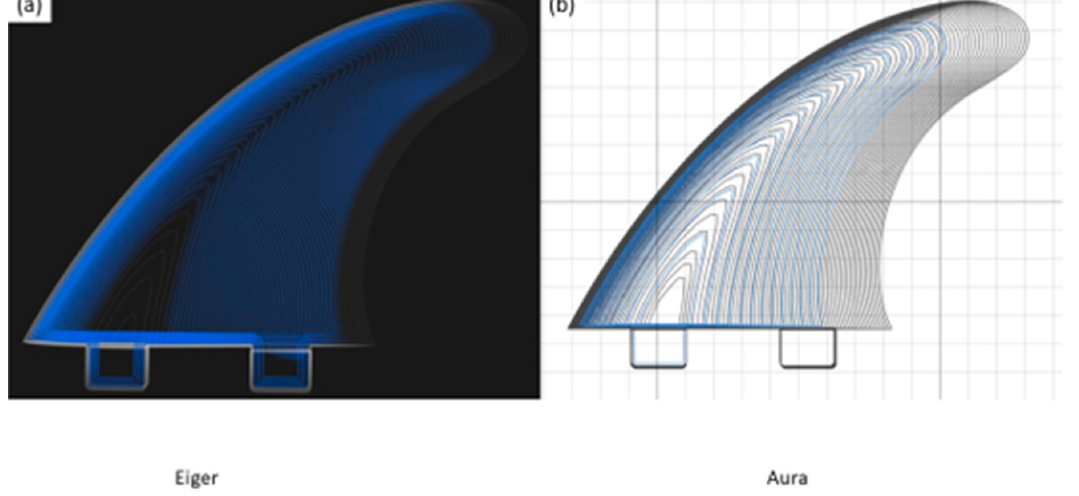
Figure 9. Comparison of ( a ) Markforged “Eiger” and ( b ) Anisoprint “Aura” slicer software for fibre composite printing. The Eiger software facilitates fibre placement in tighter spaces, with blue lines indicating fibre paths.